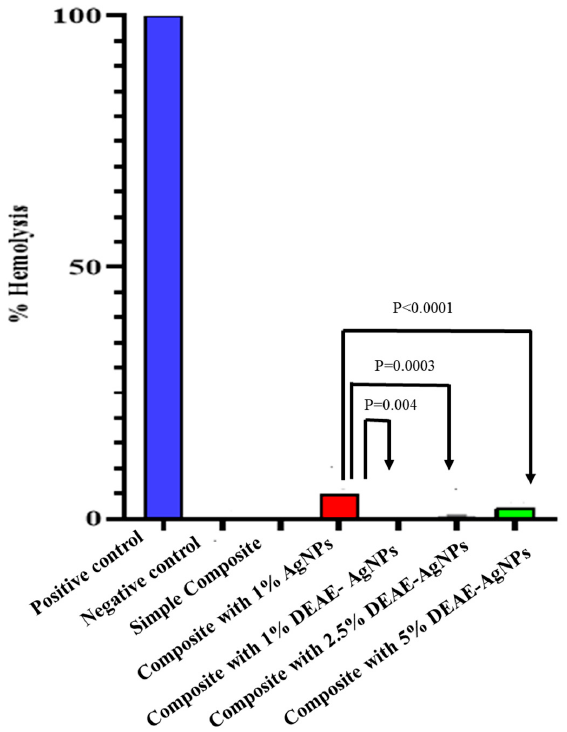
Figure 7. Hemolytic activity of composite resin, AgNPs, and DEAE-Dextran AgNPs. Statistically significant changes from untreated composite resin ( p < 0.0001). significant changes from untreated composite resin ( p <